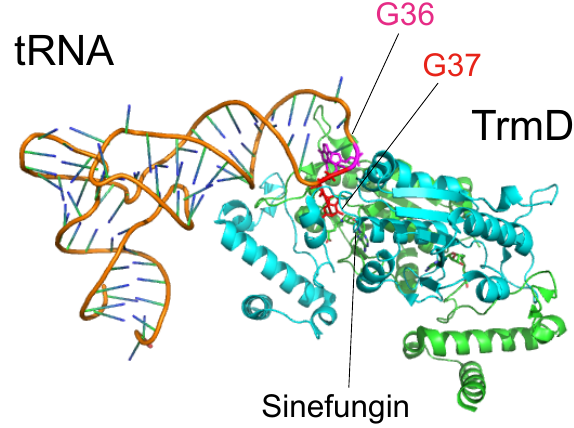
Figure 7. Structure of tRNA-TrmD-sinefungin ternary complex. The Protein Data Bank ID is 4yvi. TrmD and tRNA are shown by cartoon models. G36 (magenta) and G37 (red) bases in tRNA are highlighted by stick models. Two subunits of TrmD are colored in green and